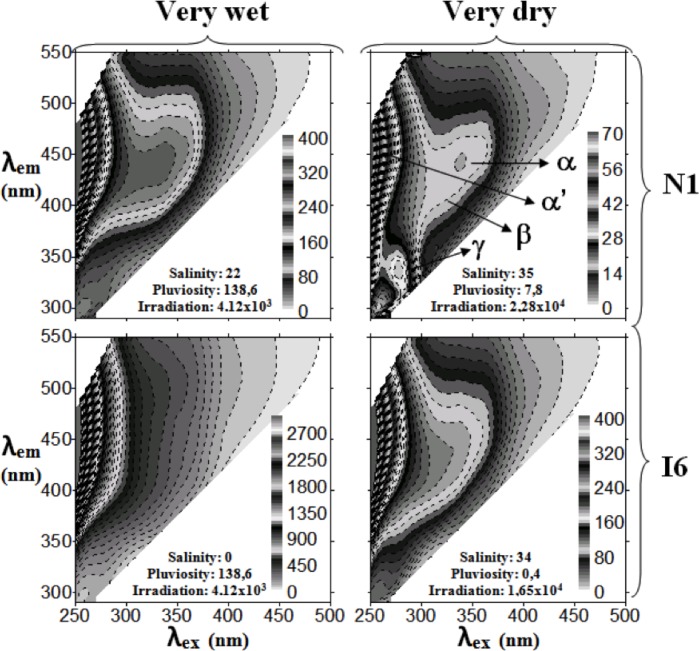
Contour EEM plots of 4 samples corresponding to group 1 (dry weather) and group 4 (very wet weather) from sampling stations N1 (marine zone) and I6 (brackish zone).